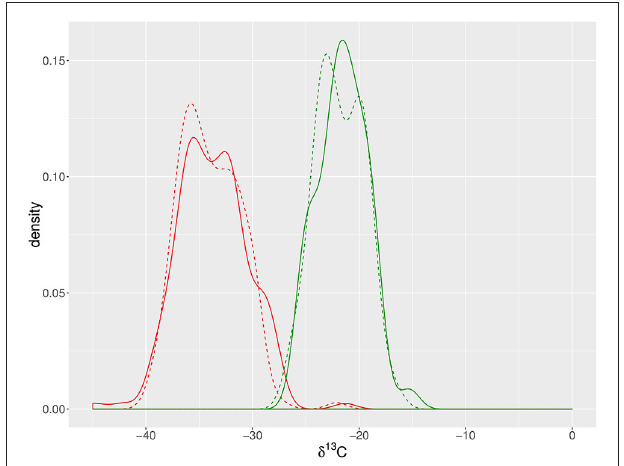
FIGURE 1 | Density plot of n -C 29 and n -C 31 alkane δ 13 C values from C 3 and C 4 plants. n -C 29 (solid lines) and n -C 31 (dashed lines) alkanes from C3 plants (red) show a 1 σ variation of 3.3 and 3.0 ‰ , respectively, while the same alkanes have 1 σ variations of 2.3 and 2.3 ‰ in C 4 plants (green). Data shown are from 10 published studies (see Supplementary Dataset 1). Lines represent the kernel density estimates generated using Gaussian kernels with bandwidths chosen by Silverman’s “rule of thumb” (Silverman, 1986).